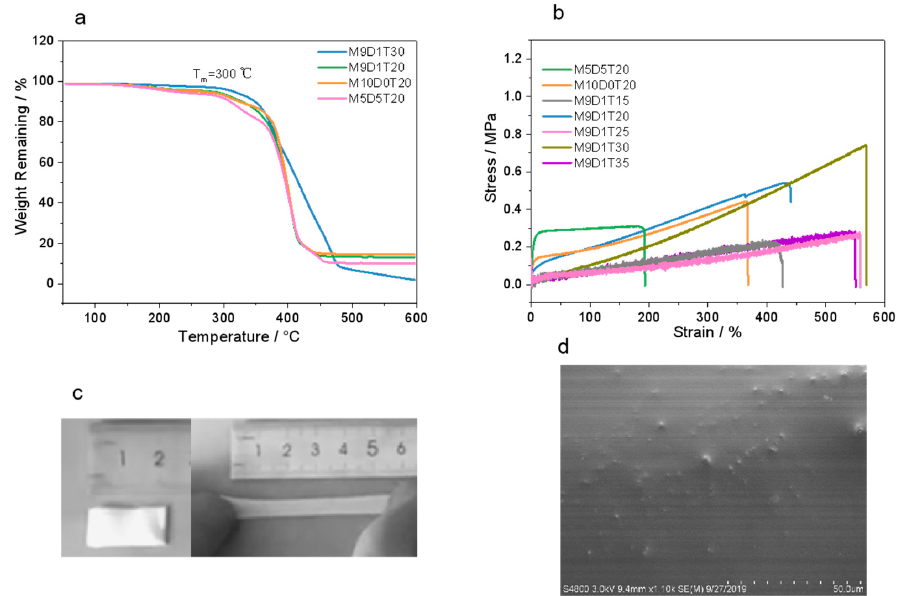
Figure 2. TGA curves ( a ) and Stress–strain curves ( b ) of double-network PEs with different ratios of TEOS and zwitterions. ( c ) Digital images of M9D1T20 before and after stretching. ( d ) Surface SEM image of M9D1T20.